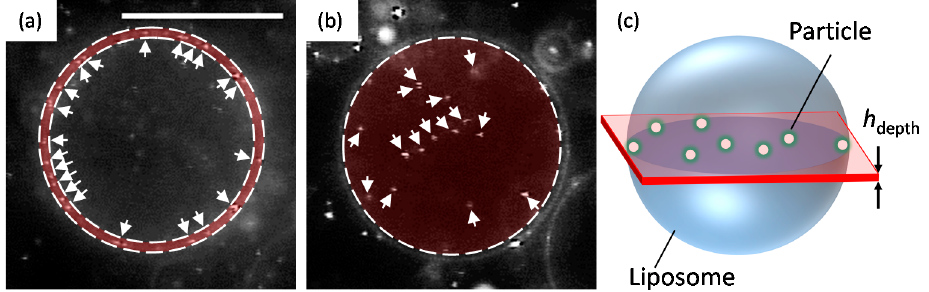
Figure 7. Regions for counting ( a ) fully wrapped particles and ( b ) penetrated particles. The white arrows indicate particles. Scale bar is 20 µm. ( c ) Schematic of the region observed by an optical microscope.